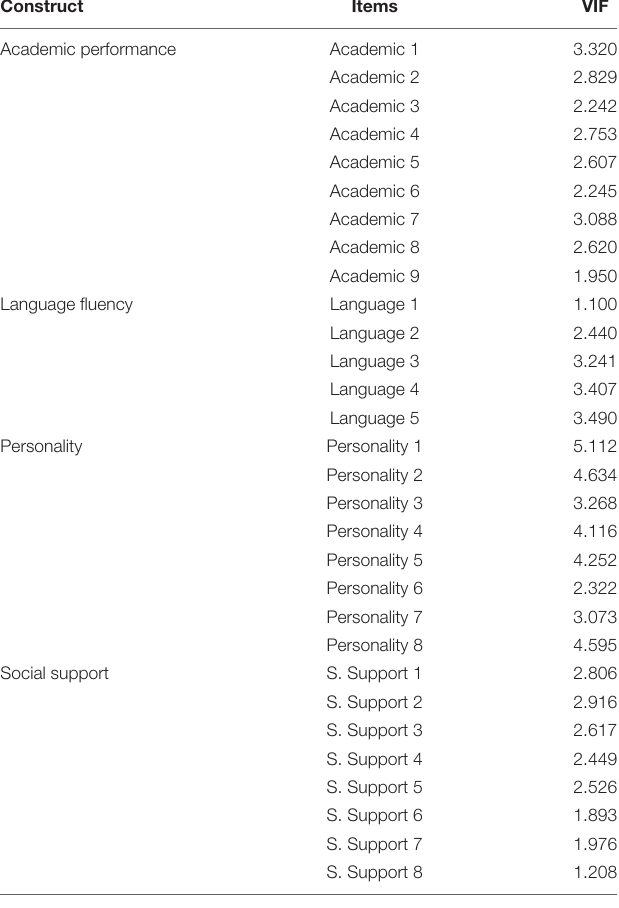
TABLE 5 | Variance inflation factor (VIF).